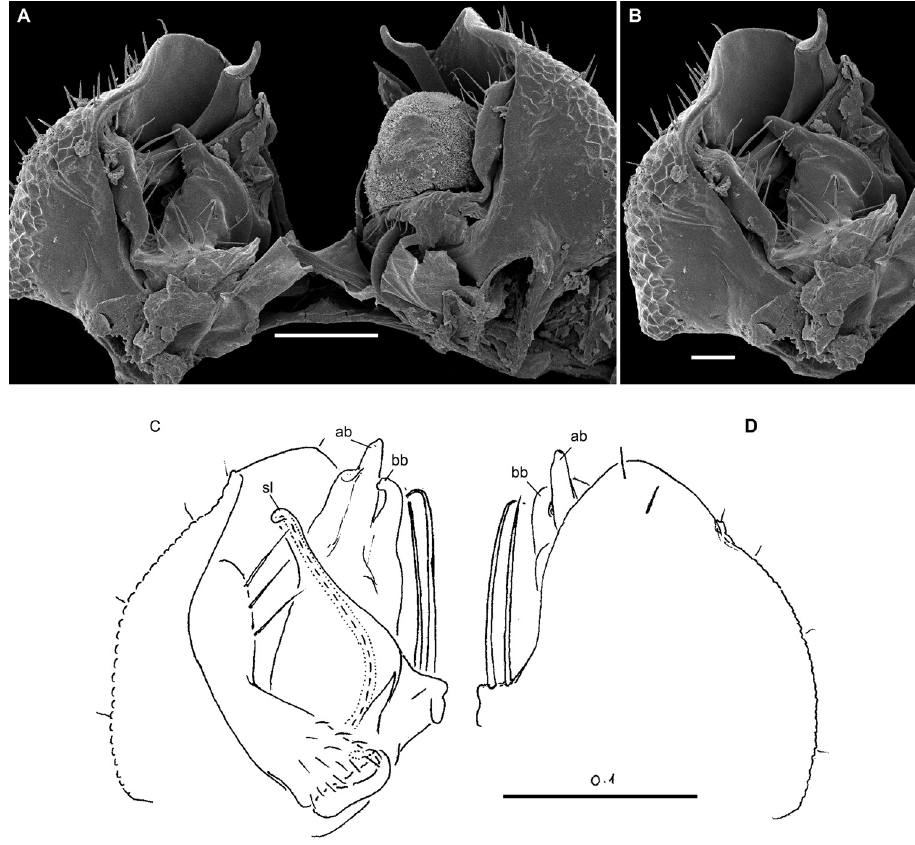
Figure 26. Hemisphaeroparia mouanko sp. n., ♂ paratypes A SEM micrographs of both gonopods in situ, ventrocaudal view B SEM micrographs of right gonopod, ventrocaudal view C, D left gonopod, mesal and lateral views, respectively. Scale bars: 0.1 mm ( C, D ), 0.05 mm ( A ), 0.02 mm ( B ). Abbreviations: ab apical branch of telopodite, bb basal branch of telopodite, sl